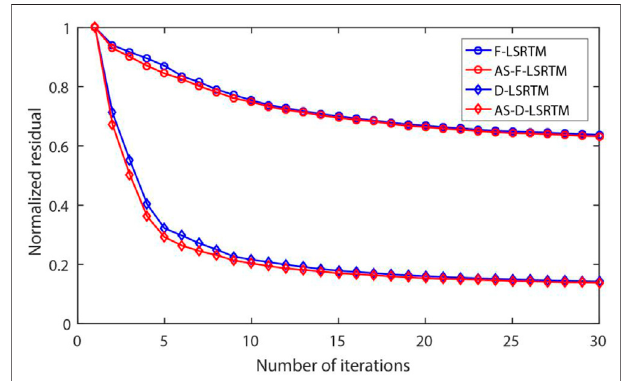
FIGURE 13 | Normalizedresidualconvergencecurvesofthefourmethods.